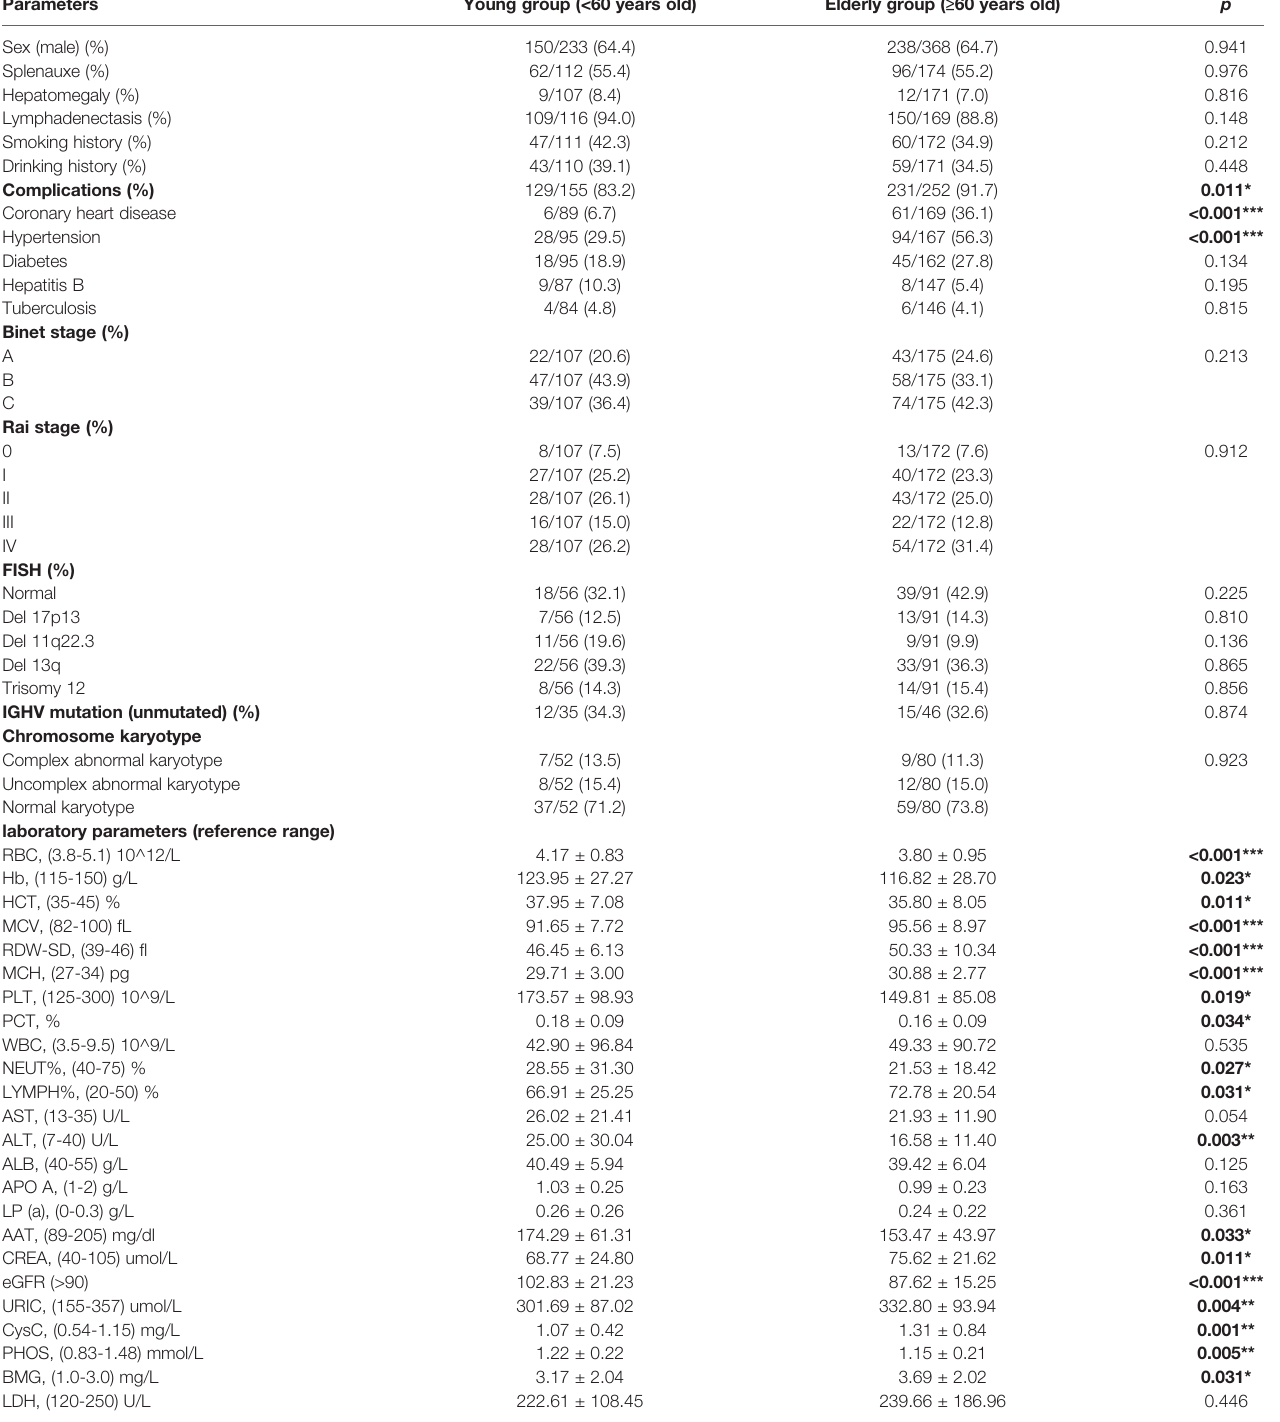
TABLE 1 | Clinical-pathological parameters in young and elderly CLL patients.